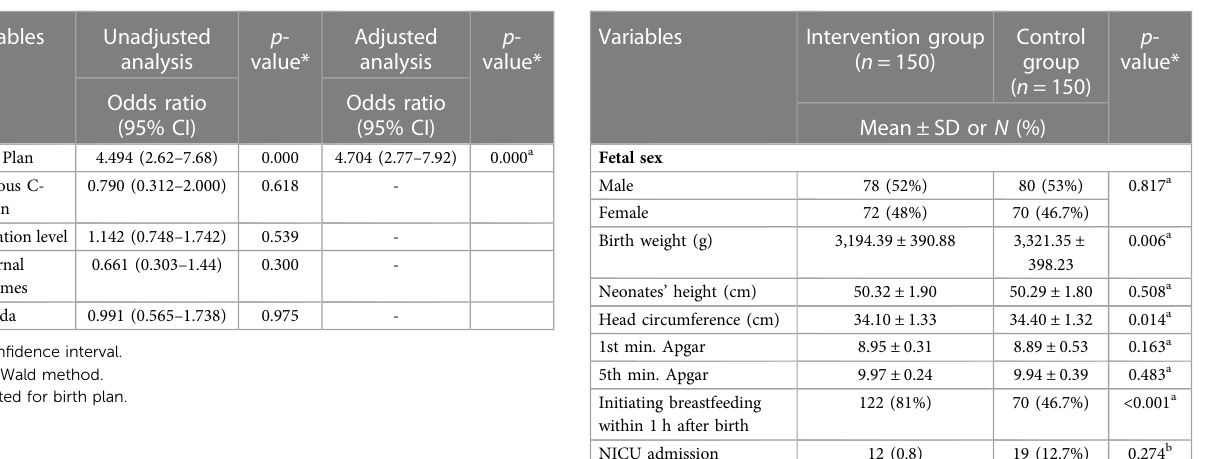
TABLE 5 Neonatal characteristics, and outcomes in intervention and control